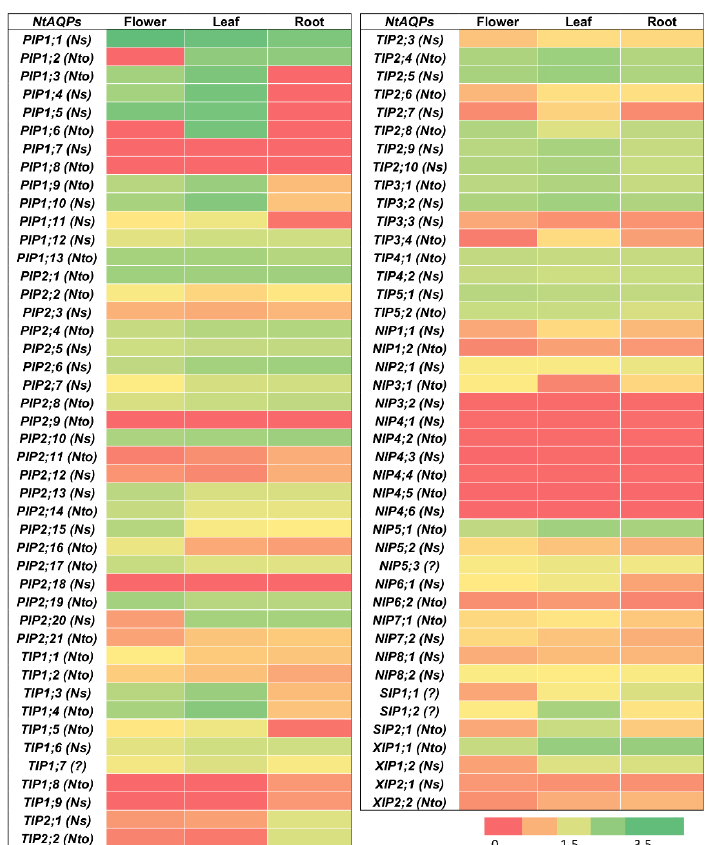
Figure 5. Expression analyses of 88 NtAQP genes in root, leaf, and flower. Color scale represents logarithmic FPKM values, where green indicates high expression and red indicates no or very low expression. Ns and Nto in parentheses indicate that corresponding NtAQP gene evolved from N. sylvestris (Ns) or N. tomentosiformis (Nto). Question mark (?) indicates that NtAQP gene origin ( N. sylvestris or N. tomentosiformis ) was not identified.